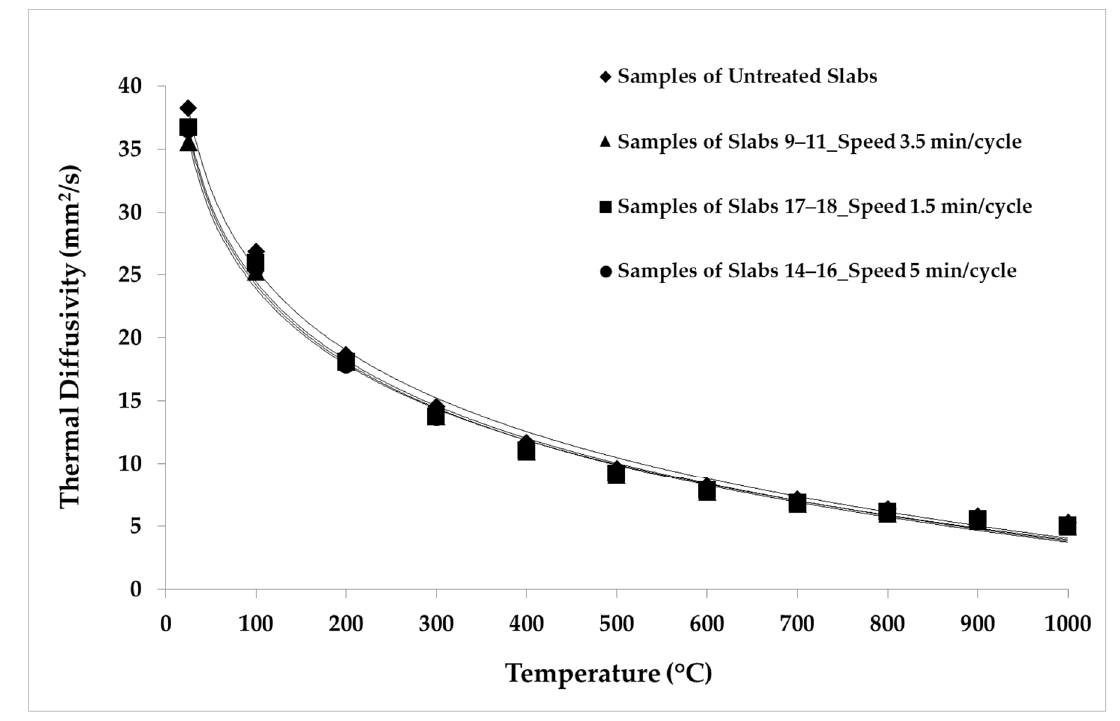
Materials 2021 , 14 , x FOR PEER REVIEW Figure 8. Thermal diffusivity values considering different speed of thermal cycles.